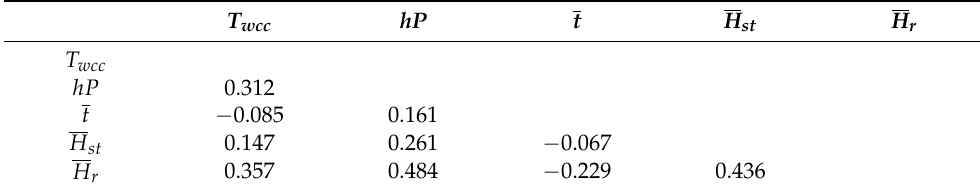
Table 4. PC correlation